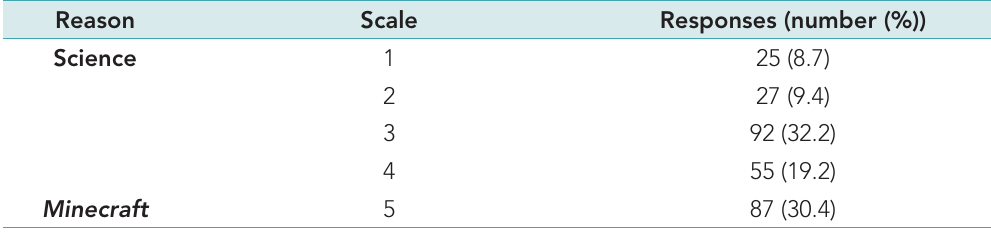
Table 4: Distribution of responses for driving factor behind choosing the Science Hunters activity from the programme of activities available (the balance between science and Minecraft was indicated on a Likert scale of 1 (science) to 5 ( Minecraft